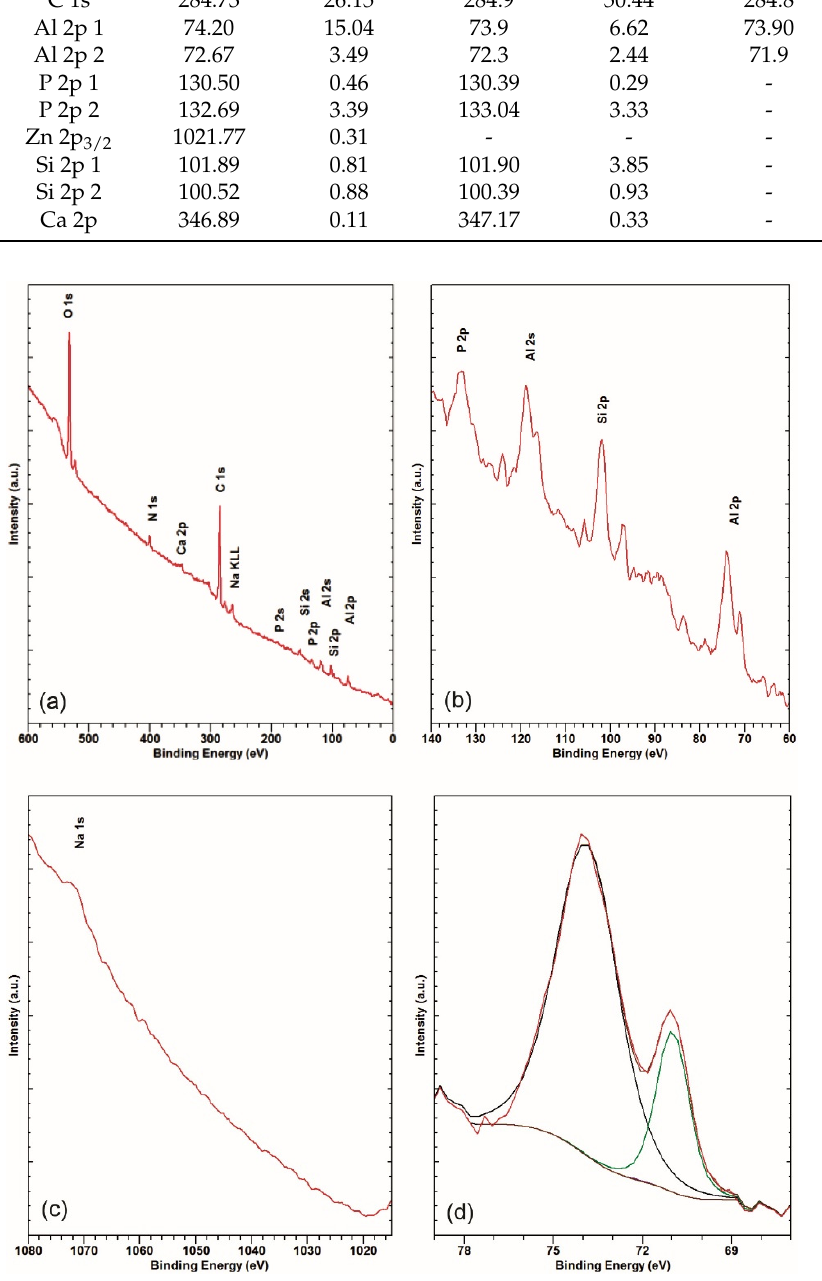
Figure 3. XPS survey ( a ), 60–140 eV region ( b ), region around Na 1s, Zn 2p ( c ), and narrow-range Al 2p ( d ) spectra in the undegraded area. 2p ( d ) spectra in the undegraded